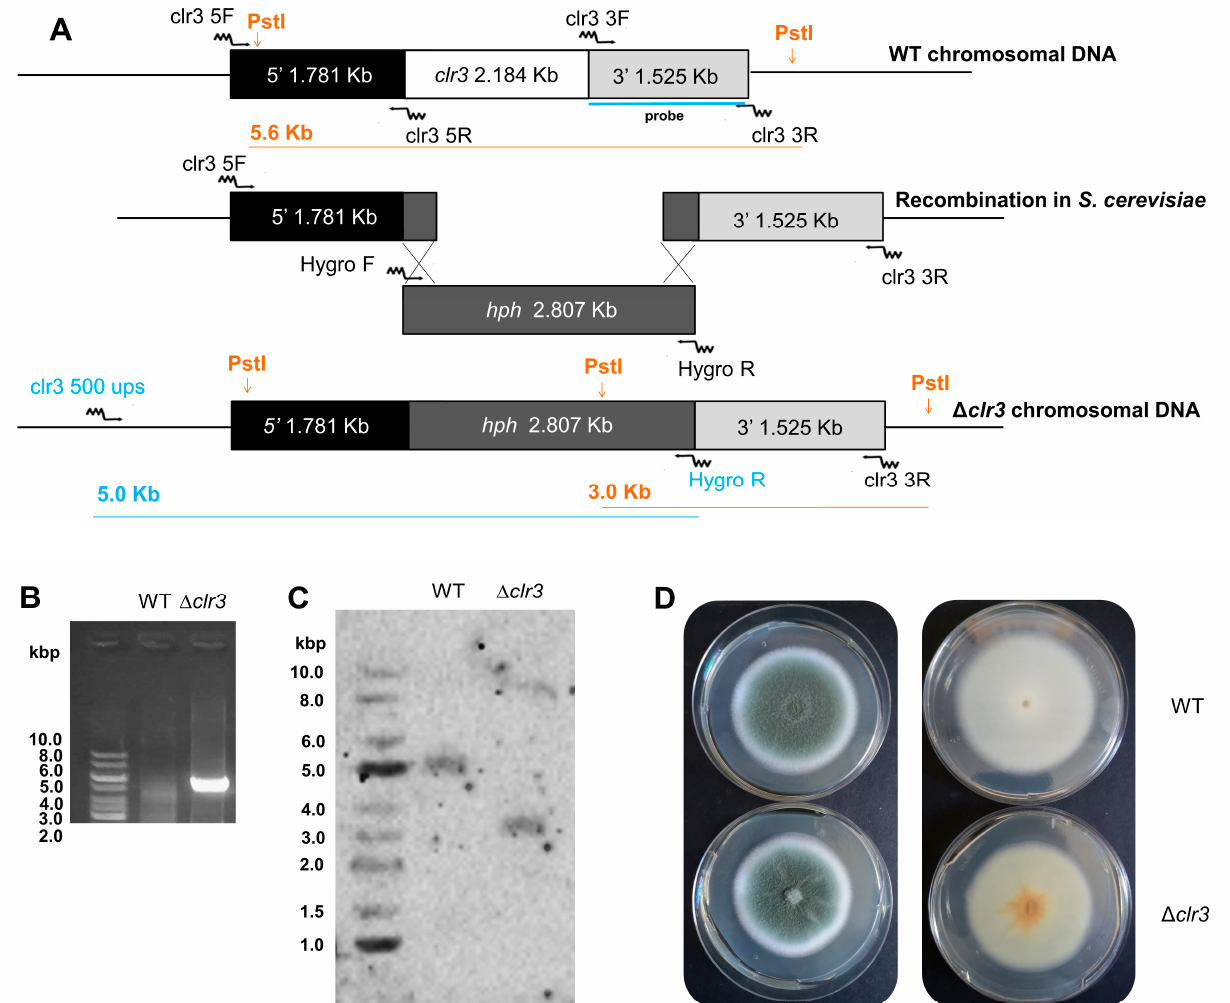
Figure 1. Construction of clr3 deletion mutant. Gene replacement strategy for clr3 deletion, in which the hph gene was used as a selection marker. The primer names and annealing regions are indicated by arrows (primer sequences are described in Table S1). Deletion cassettes were constructed by in vivo recombination in S. cerevisiae ( A ). Diagnostic PCR was performed to evaluate clr3 loci after gene replacement using primers located 500 bp upstream of the deletion cassette, shown in blue letters and arrows. No amplification was observed in the wild-type (WT) strain ( B ). Southern blot analysis indicating the hybridization of the probe, which recognizes the region indicated by orange letters and lines ( C ). Phenotype of the Δ clr3 and wild-type (WT) strains grown in PDA at 30 °C for 7 days ( D ), top (left) and bottom (right) of the colony.